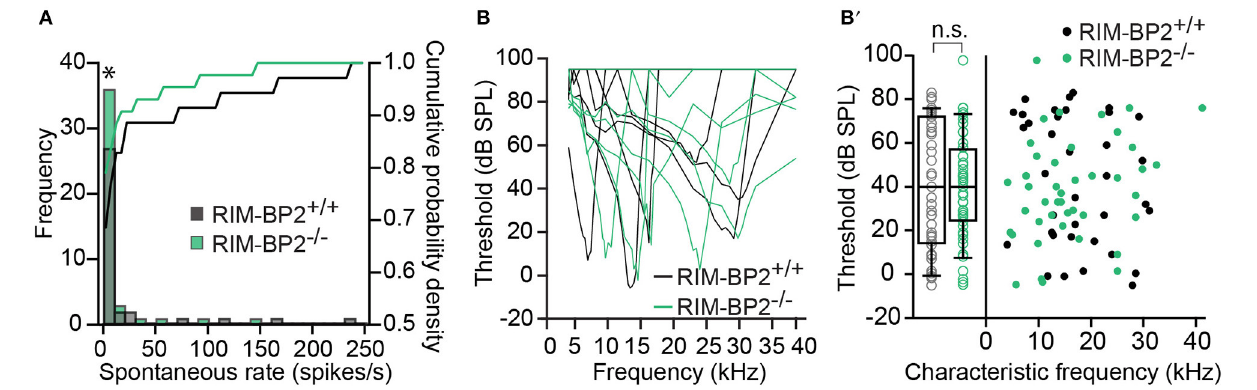
FIGURE 11 | Higher fraction of fiber with low spontaneous firing rates in single unit recordings from RIM-BP2 − / − auditory nerve fibers (A) Distribution of spontaneous firing rates of single units in RIM-BP2 + / + (black; n = 35; N = 6) and RIM-BP2 − / − (green; n = 43; N = 3) auditory nerve fibers (ANFs). The histogram represents the distribution of their frequency (left y-axis) and the solid lines represent the cumulative probability density (right y-axis) of spontaneous firing rates. The fraction of ANFs with low spontaneous firing rates was significantly higher in RIM-BP2 − / − mice. Wilcoxon rank test, p = 0.04. (B) Representative tuning curves of ANF from RIM-BP2 + / + (black; n = 36; N = 6) and RIM-BP2 − / − (green; n = 43; N = 4) mice demonstrate easily distinguishable characteristic frequencies. (B ′ ) ANF sound thresholds at their characteristic frequency were comparable between the two genotypes: 41.68 ± 5.03 dB for RIM-BP2 + / + ( n = 36; N = 6) and 38.42 ± 3.6 dB for RIM-BP2 − / − ( n = 43; N = 4). Student’s t -test, p = 0.60. Each data point represents the response of single unit of ANF. (A,B) Data information: significance levels: n.s. p ≥ 0.05, * p < 0.05; n = number of single units of ANFs and N = number of mice. Box and whisker plot represents median, lower/upper quartiles and 10th − 90th